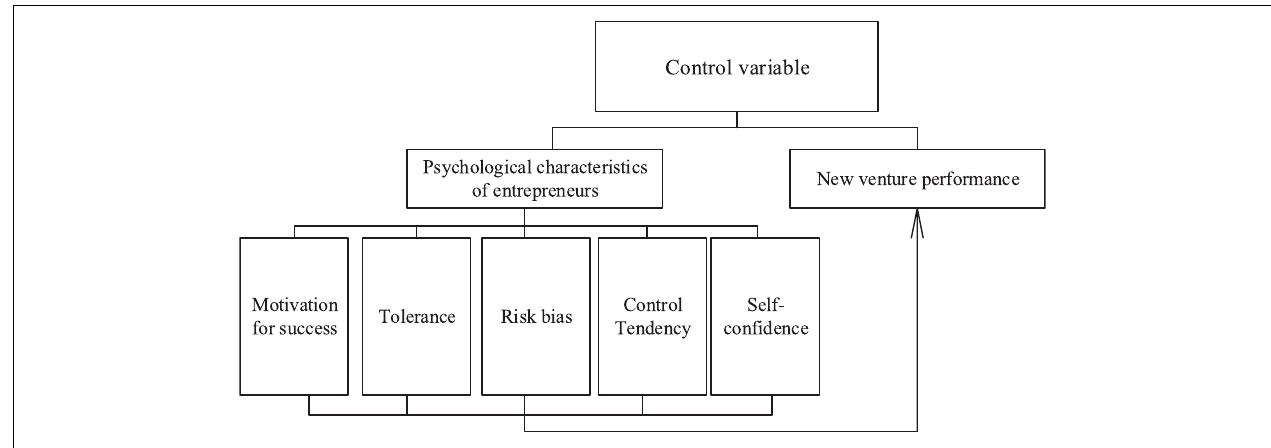
FIGURE 1 | Multidimensional structure model.